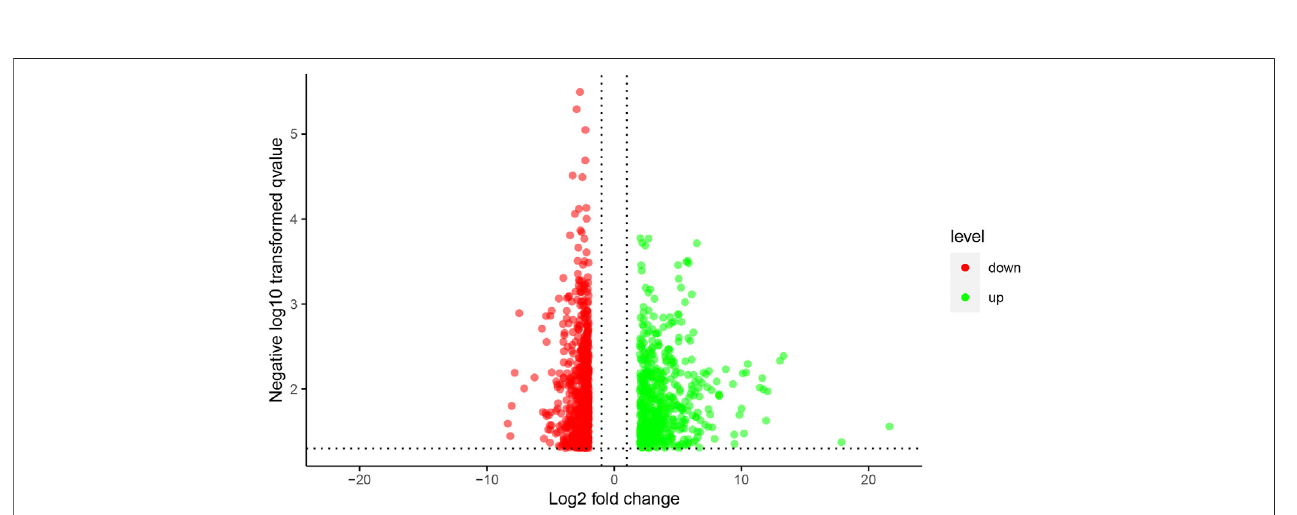
FIGURE 3 | The volcano fi gure ofmRNA expression pro fi le microarray. Notes: Red dots indicate up-regulation genes, green dots indicate down-regulation genes.